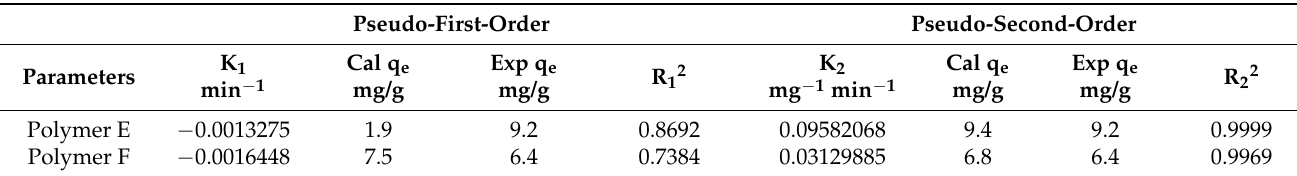
Figure 10. Kinetics curves of pseudo-first-order and pseudo-second-order model. Experimental conditions were, MB concentration 100 mg/L; adsorbents hydrogel dose 250 mg in 25 mL; pH 9; RT. Table 4. Polymer E and F kinetic parameters for MB adsorption.